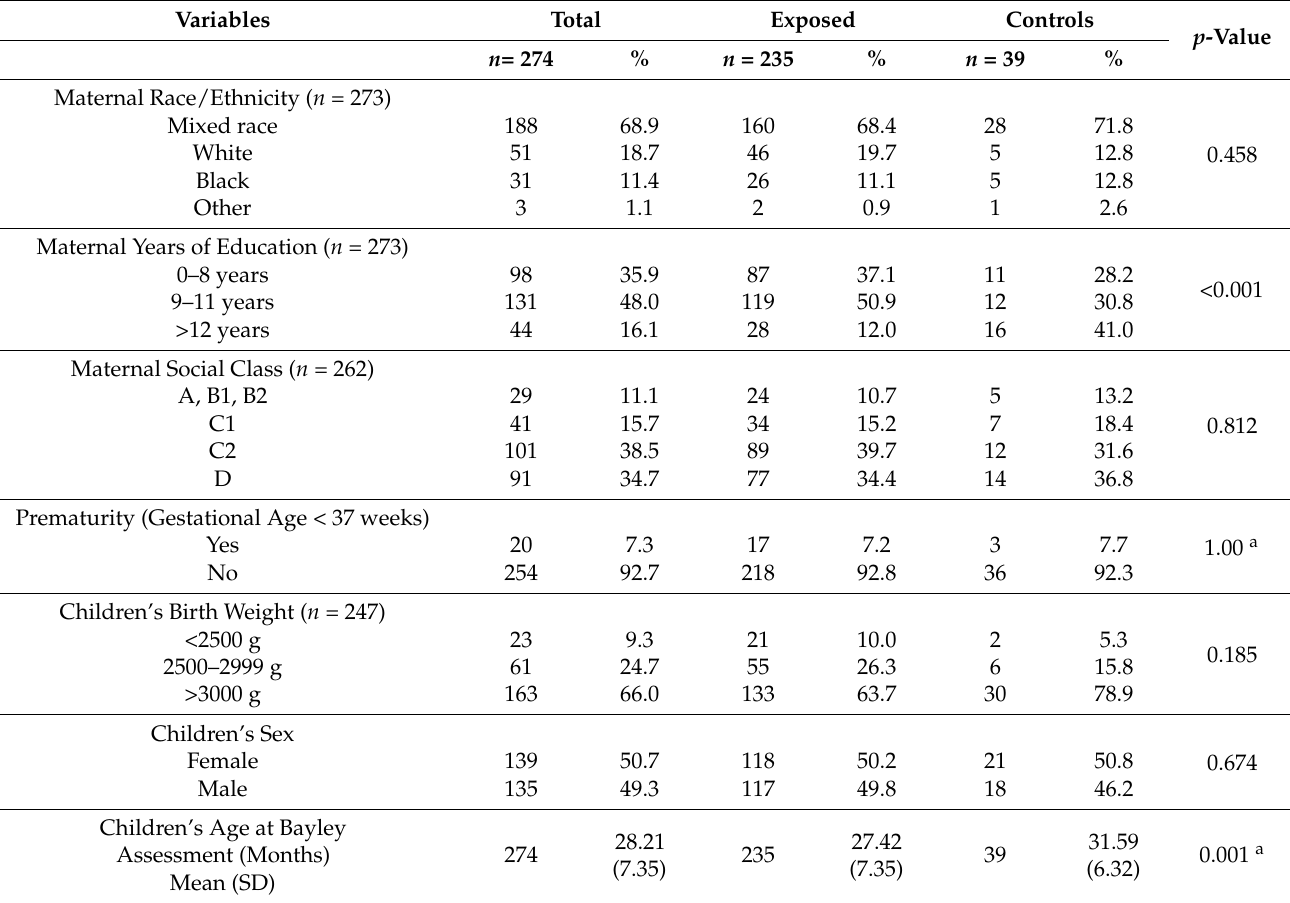
Table 1. Selected characteristics of mothers and children with prenatal exposure to ZIKV born without microcephaly and the group of controls. Variables Total